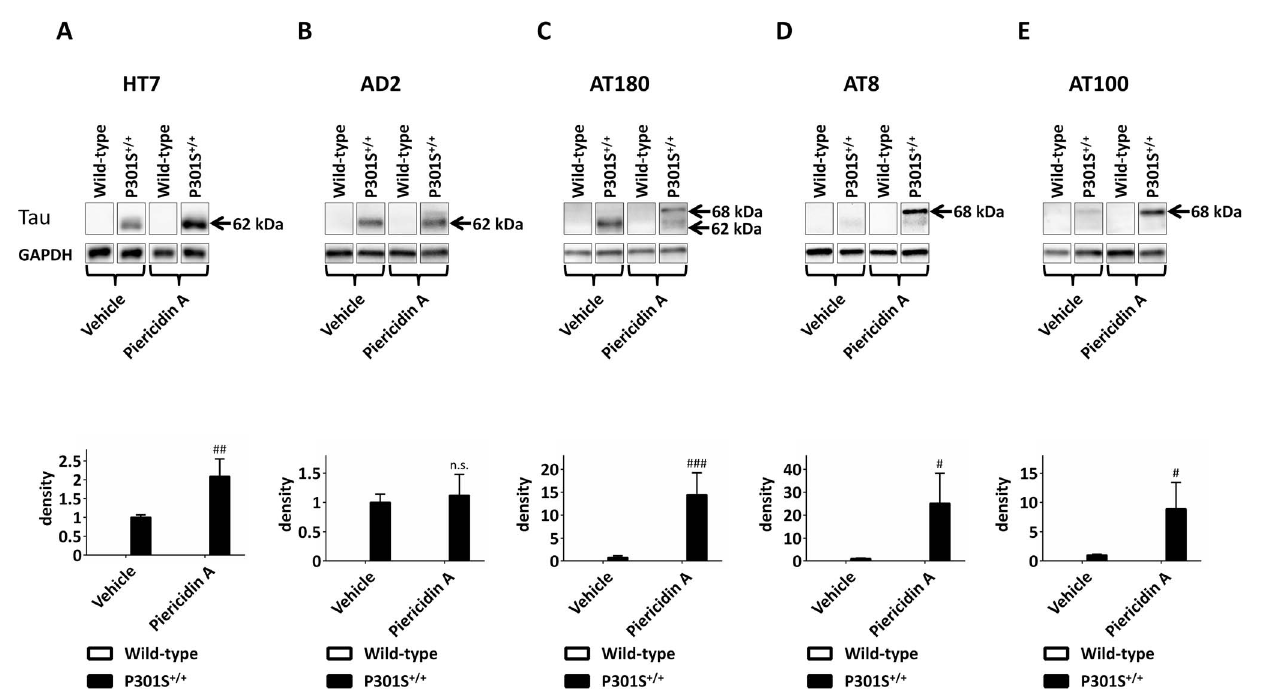
Figure 4. Western blots showing the effect of piericidin A treatment on total tau and phospho-tau levels. Upper panels: Western blots of wild-type and P301S + / + mice, exposed to Piericidin A or vehicle over a period of 28 days, stained with an antibody specific for human tau (HT7, A), an antibody against pSer396/Ser404 (AD2) phosphorylated tau (B), an antibody against pSer202/Thr205 (AT8) phosphorylated tau, an antibody against pThr231 (AT180) phosphorylated tau (C), and an antibody against pThr212/Ser214 (AT100) phosphorylated tau (E). Below the tau Western blots the glyceraldehyde 3- phosphate dehydrogenase (GAPDH) loading control is shown. Lower panels: Quantification of the Western blots after normalization to loading control (GAPDH). In the HT7 and AD2 Western blots, the whole visible band was quantified, whereas in AT180, AT8 and AT100 the 68 kDa band was quantified. # p , 0.05, ## p , 0.01, ### p , 0.001, n.s. not significant, piericidin A treatment vs. vehicle treatment at the same genotype. Two-way ANOVA with Fisher LSD post-hoc